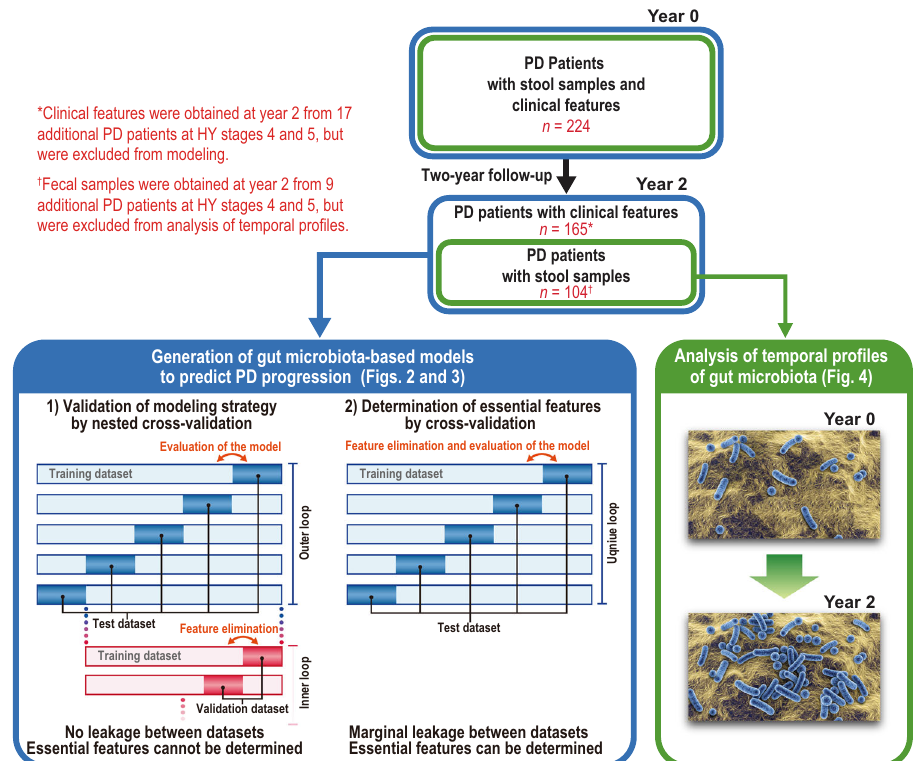
Fig. 1 Illustration of work fl ows of this study. Fecal samples and clinical features were obtained at year 0 in 224 PD patients. At year 2, clinical features were evaluated in 165 PD patients, and fecal samples were obtained in 104 PD patients. Although clinical features were evaluated at year 2 in 17 additional PD patients (a total of 182 patients), they were excluded from making prediction models (see Materials and Methods). Similarly, fecal samples were obtained at year 2 in nine additional PD patients (a total of 113 patients), but they were excluded from analysis of temporal pro fi les of gut microbiota. Bacterial and clinical features at year 0, as well as clinical features at year 2, in 165 PD patients were used for Figs. 2 and 3. Gut microbiota at years 0 and 2 in 104 PD patients were used for Fig. 4. Construction of prediction models was constituted of two steps: (1) nested cross-validation has no leakage between the training and test datasets, and is for evaluation of the modeling strategy, and (2) cross-validation has marginal leakage between the training and test datasets, and is for determination of essential features to predict the progression of PD. Recursive feature elimination (FRE) was employed in both steps. AUROCs were calculated in both steps, but AUROC of the nested cross-validation should be dependable because of lack of potential